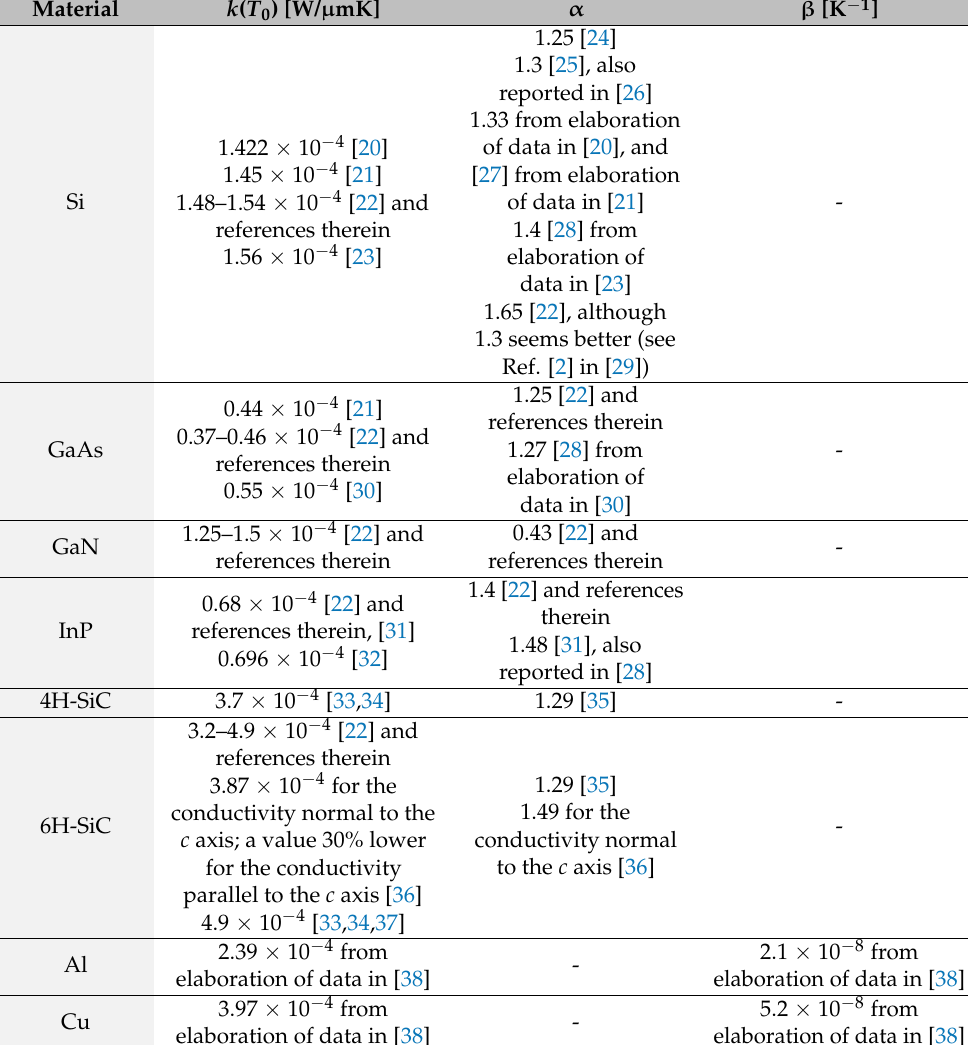
Table 1. Quoted values of parameters in (3), (4) for the most important semiconductors and metals in electron